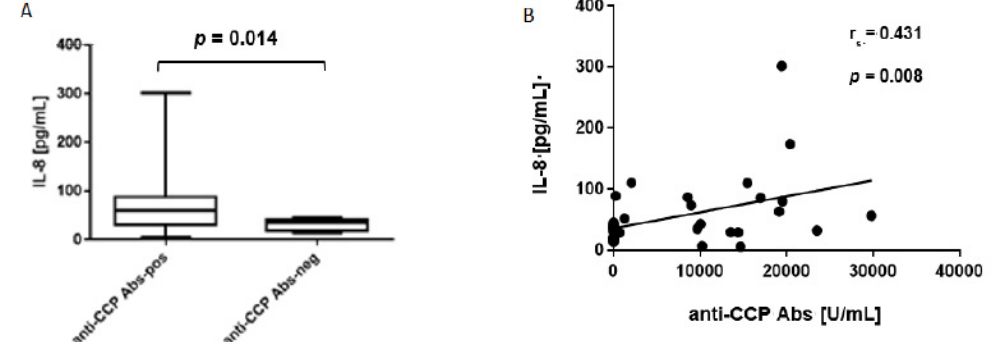
Figure 2. Concentrations of IL-8 in the bone marrow of RA patients. ( A ) Concentrations of IL-8 in anti-cyclic citrullinated peptides antibodies-positive (anti-CCP Abs-pos), n = 20, and anti-cyclic citrullinated peptides antibodies-negative (anti- CCP Abs-neg), n = 17, bone marrow samples. Comparison was performed using two-tailed Mann–Whitney U test. ( B ) Correlation between IL-8 and anti-CCP Abs concentrations, n = 37. The relationship between variables was measured using the Spearman’s rank correlation coefficient.